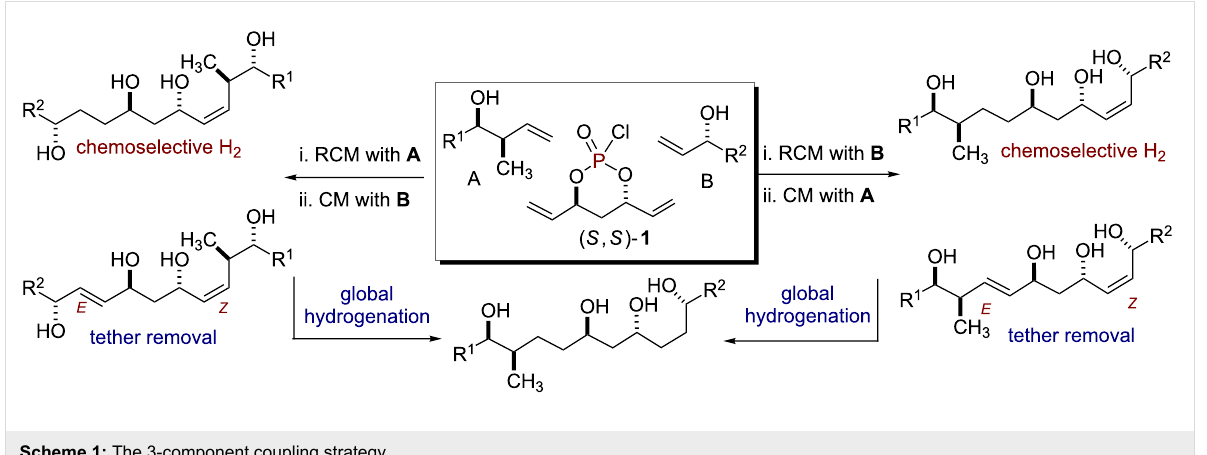
Scheme 1: The 3-component coupling strategy.